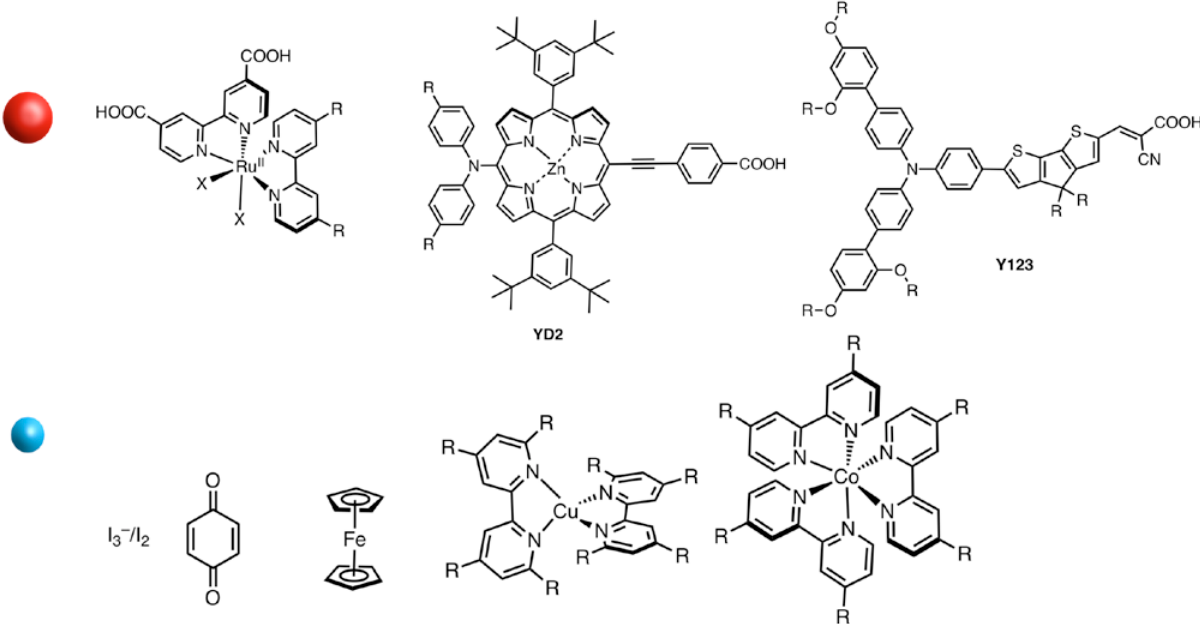
Figure 5. Structures of dye molecules (red) and redox shuttles (blue) commonly employed in DSSCs. Their roles are schematically illus- trated in Figure 1b. R represents various alkyl/alkoxy substituents while X = SCN.